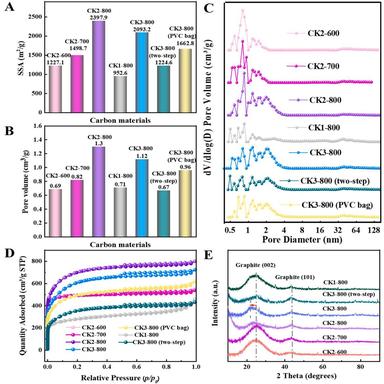
Characterization of various carbon materials: (A) surface aeras, (B) pore volumes, (C) pore size distributions, (D) adsorption–desorption curves and (E) XRD patterns.